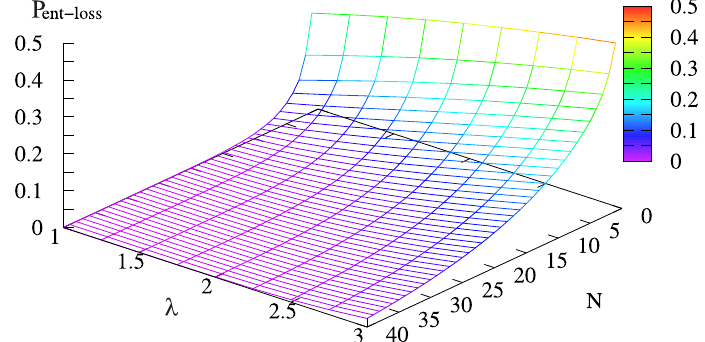
Figure 6. Dependence of the probability P ent − loss on N and λ .